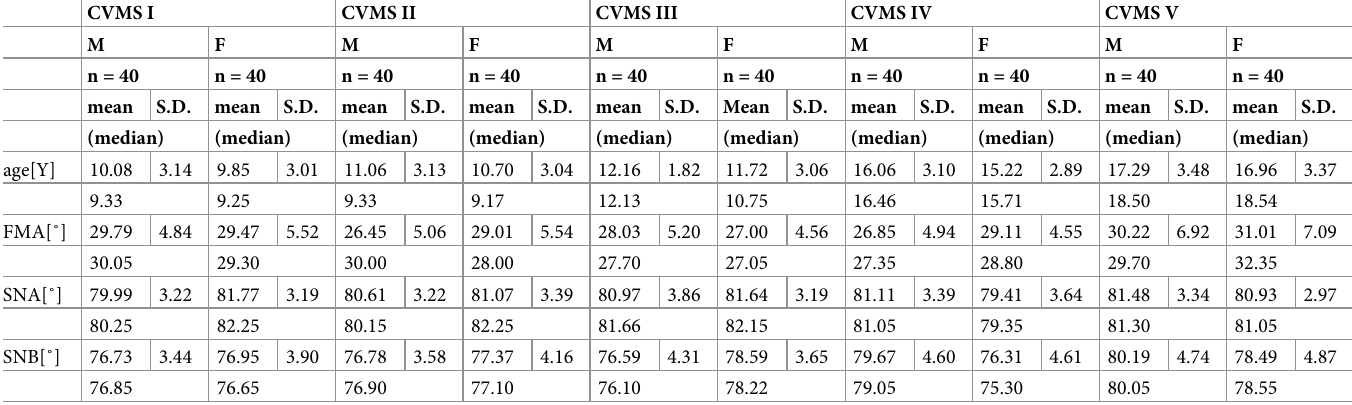
Table 1. Descriptive statistics of patient variables.